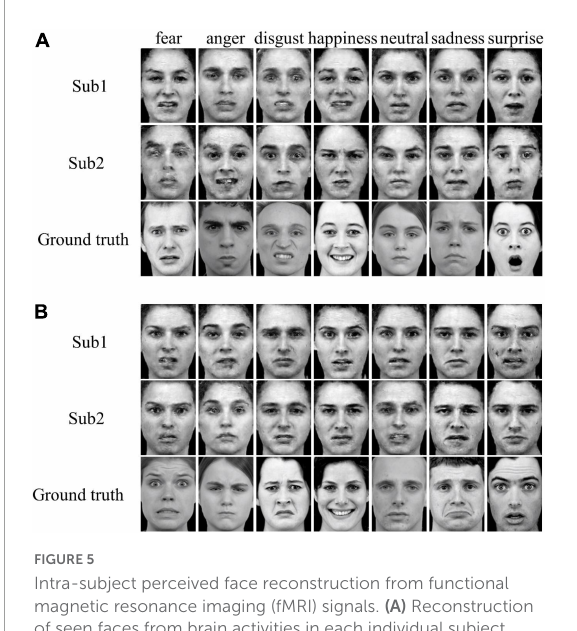
FIGURE5 Intra-subject perceived face reconstruction from functional magnetic resonance imaging (fMRI) signals. (A) Reconstruction of seen faces from brain activities in each individual subject. (B) Reconstruction of unseen faces from brain activities in each individual subject. Sub1: subject 1 (top row) ; Sub2: subject 2 (middle row) ; Ground truth: original face image stimuli (bottom row) .